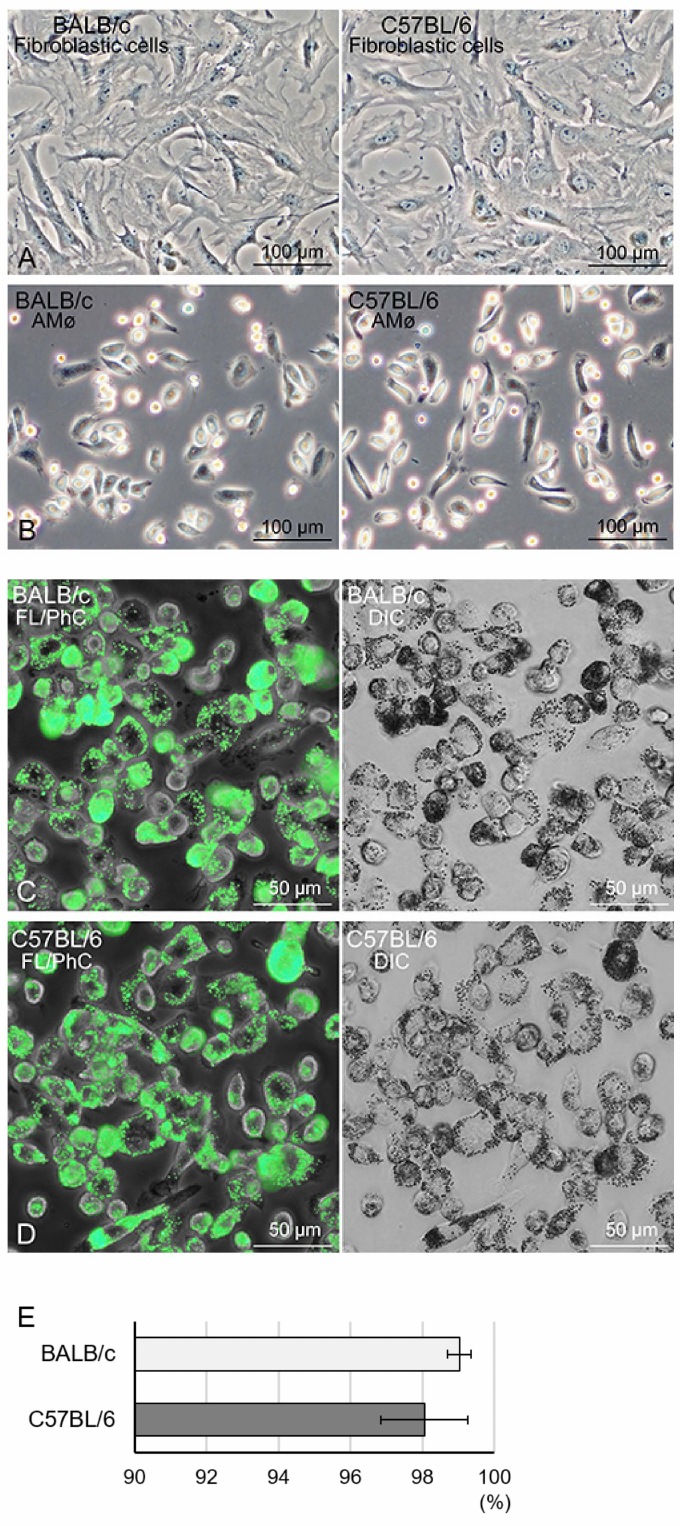
Figure 2. Phase-contrast images of lung fibroblastic cells and alveolar Mø from BALB/c and C57BL/6 mice as well as the propagated lung tissue-resident Mø demonstrating high phagocy- totic activity. ( A ): Lung interstitial cells of BALB/c ( left panel) and C57BL/6 mice ( right panel) showing fibroblastic morphology. Lung interstitial cells propagated by co-culturing with lung tissue-resident Mø were separated based on the difference of adhesive property between the two